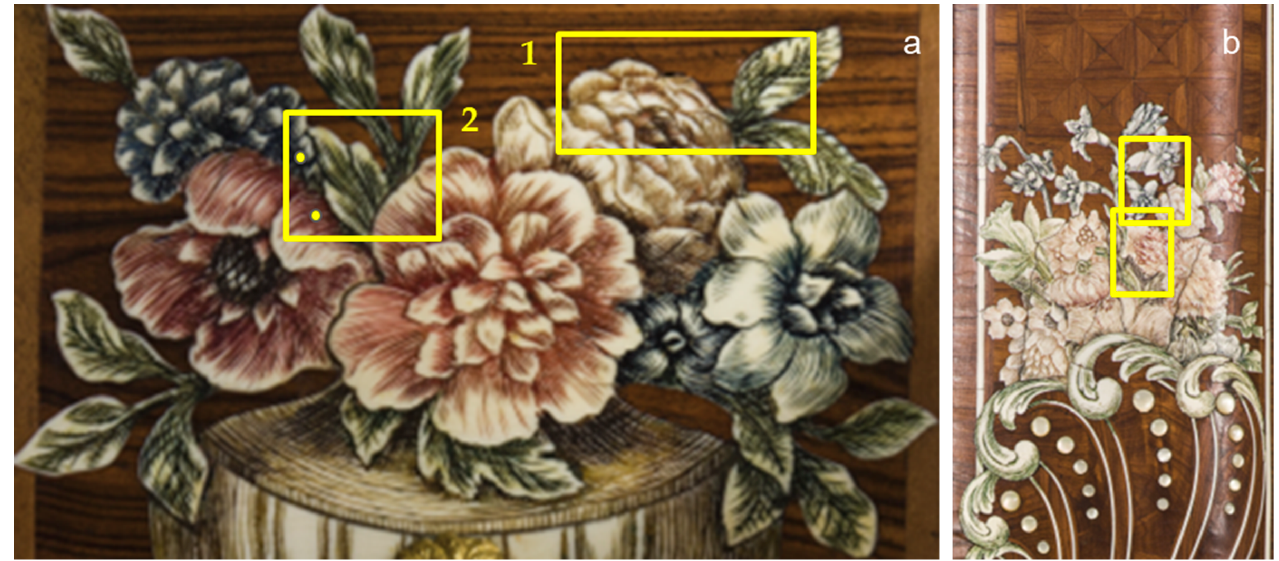
Figure 4. Selected areas for the measurements: ( a ) selected areas outlined in yellow and the two points in the black and red shades on the drawer; ( b ) particular of the external side. The scanned areas are outlined in yellow.